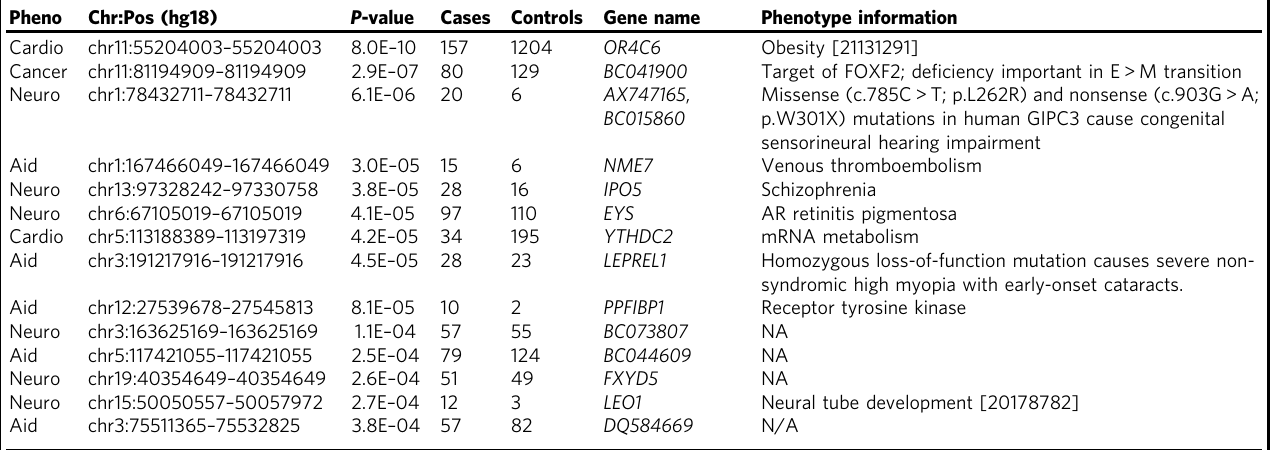
Table 2 Homozygous deletion CNVRs associated with a major disease category. Pheno Chr:Pos